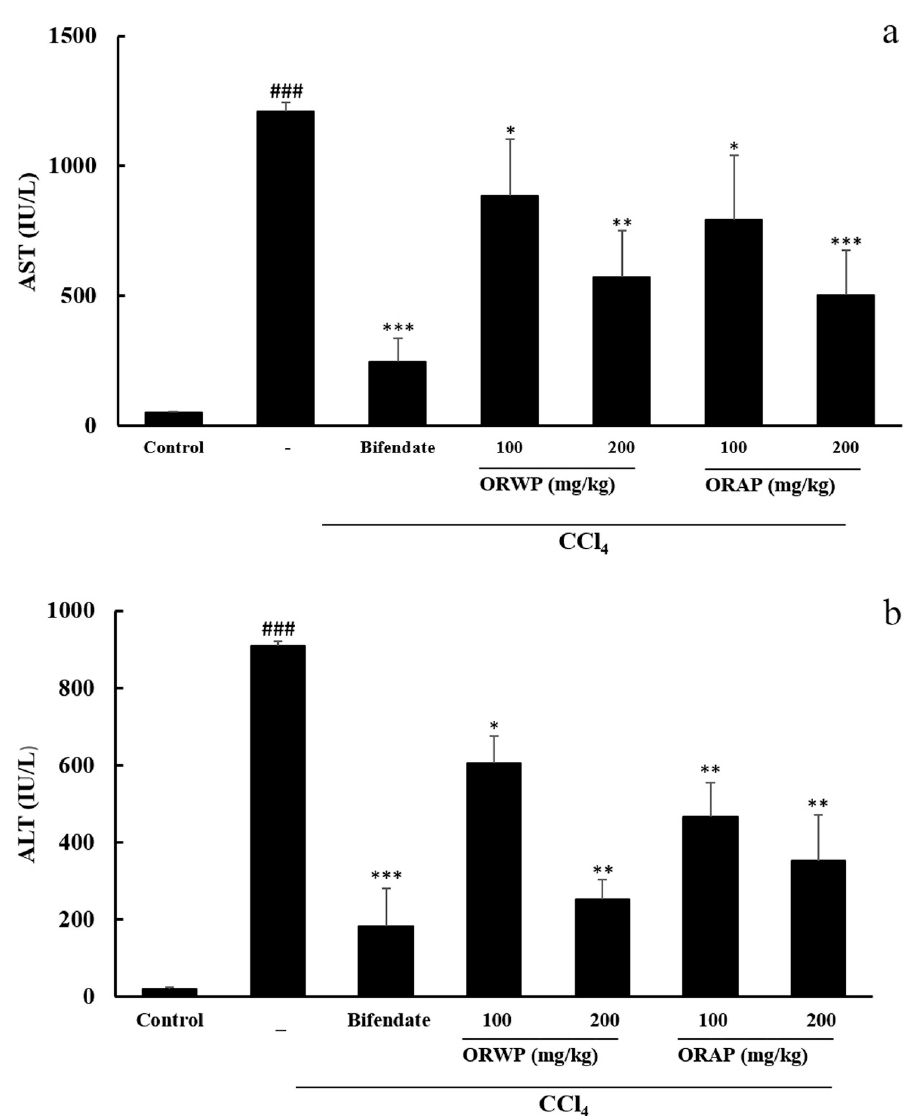
Figure 3. Effects of ORWP and ORAP on the activity of serum AST ( a ) and ALT ( b ) in CCl 4 -treated mice. The values represent means ± SD of eight mice/group. ### p < 0.001 versus normal control, *** p < 0.001, ** p < 0.01 and * p < 0.05 versus CCl 4 -intoxicated group. Hepatic MDA levels indicated lipid peroxidation in the tissue. Prominent elevation of the MDA level in the CCl 4 -intoxicated group was observed when compared with the normal control group.